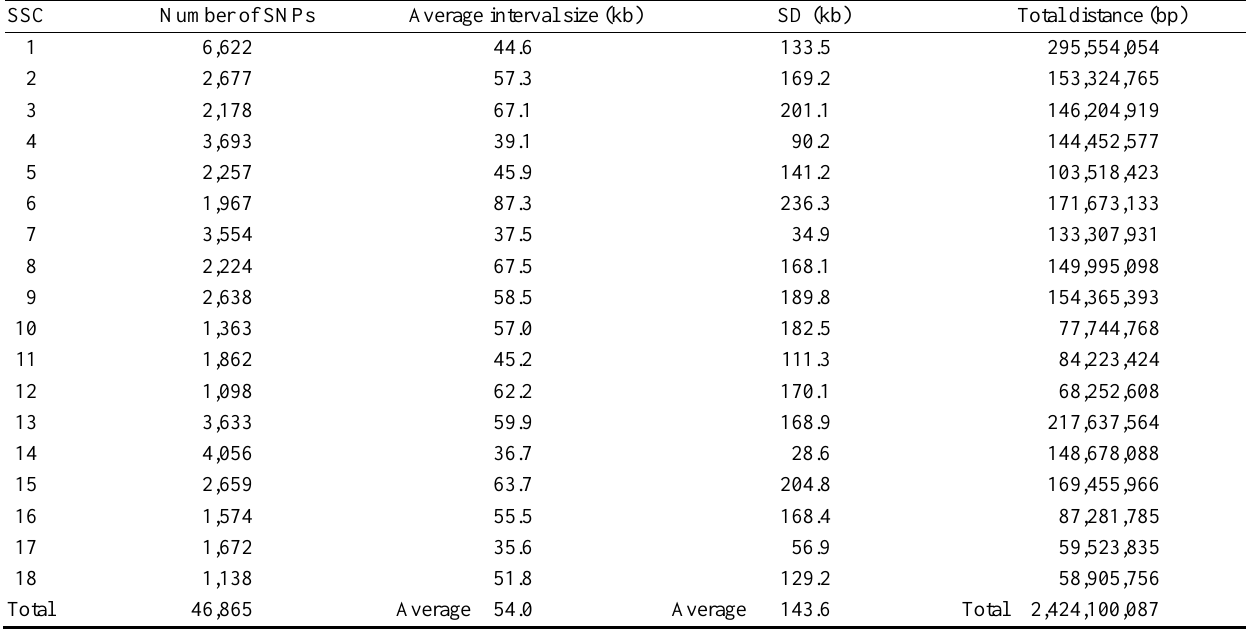
Table 2. The numbers of available SNPs and average interval distance between flanking SNPs across all 18 autosomes (SSC) in the KNP  YK F 2 population